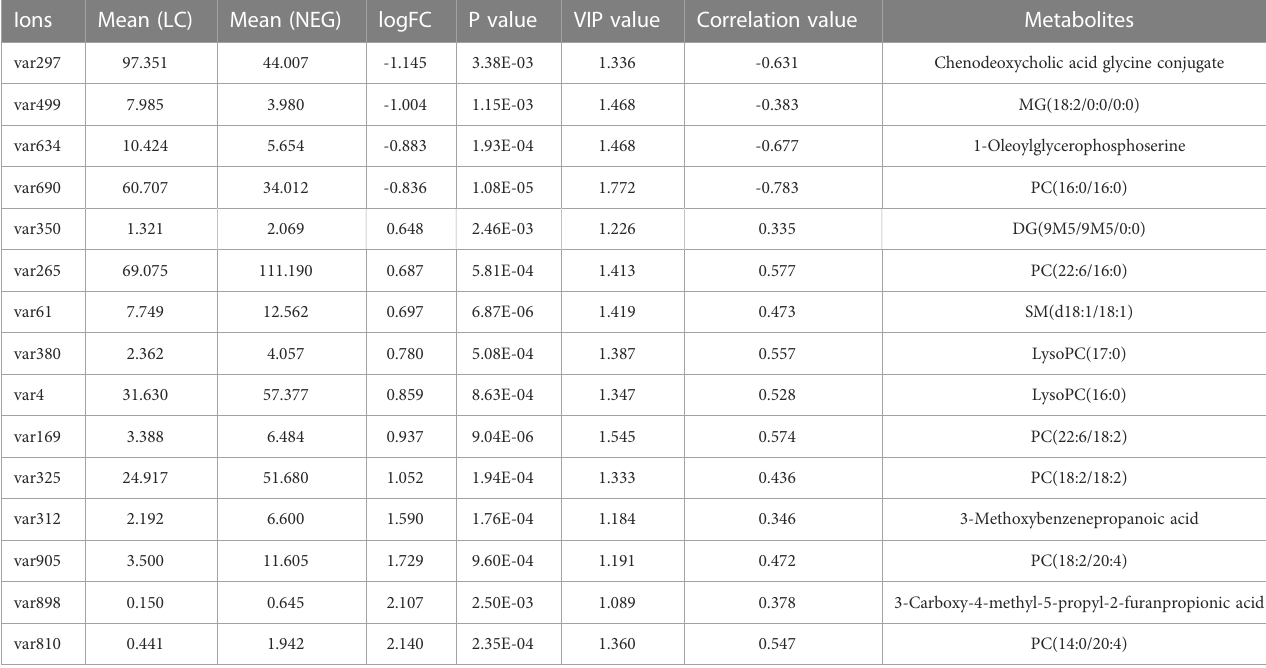
TABLE 2 Differential ions and referred metabolites between LC and NEG group.